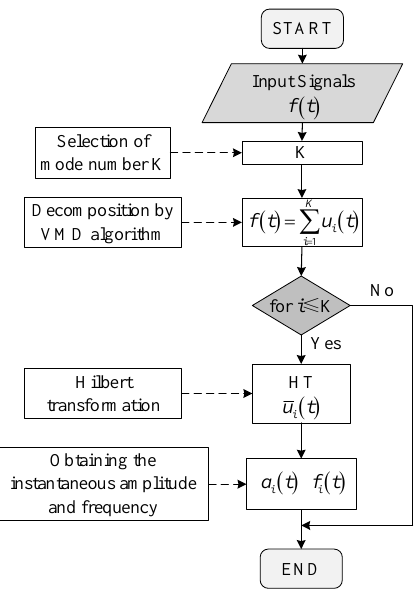
Figure 2. Flowchart of the VMD-HT (Hilbert Transform) algorithm.